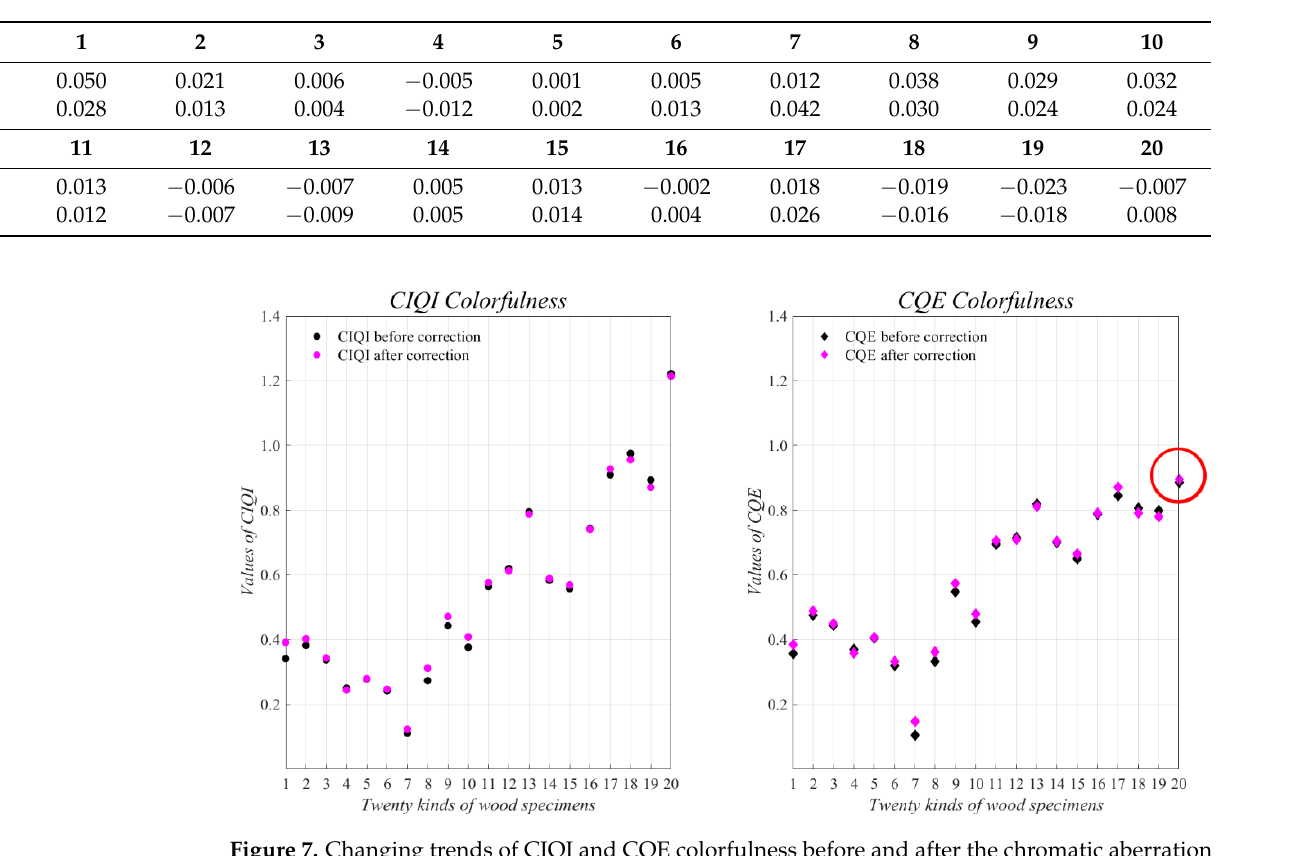
Table 4. Changes of the evaluation values of CIQI and CQE after the chromatic aberration correction.